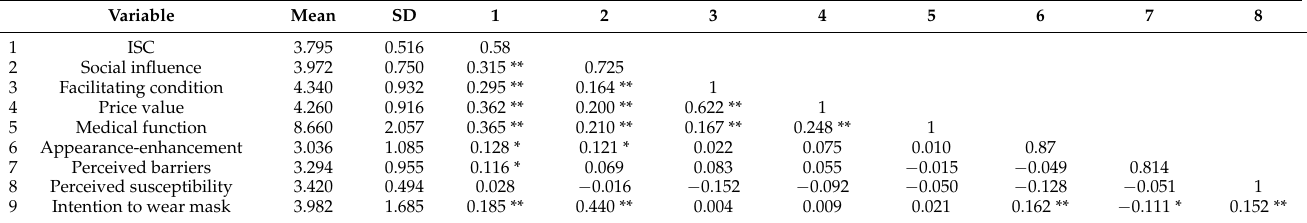
Table 2. Mean, standard deviation and correlation of the main variables.